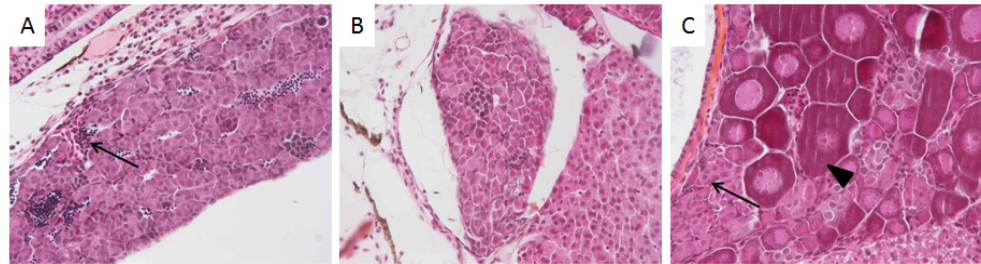
Figure 7. Testis functional disruptions. Testicular hypoplasia revealed by the low number of spermatozoa ( A ) or their absence ( B ). Ovotestis observed in HO-3X with coexistence of immature follicles (arrowhead) and spermatogonia (arrow) ( C ).